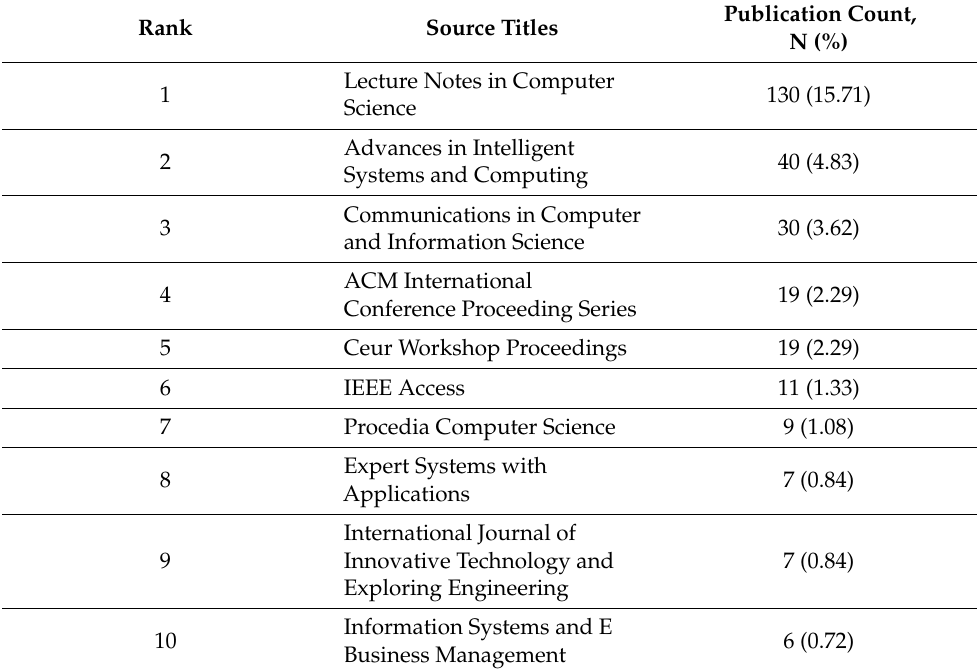
Table 12. Top ten publication sources on Scopus (N =